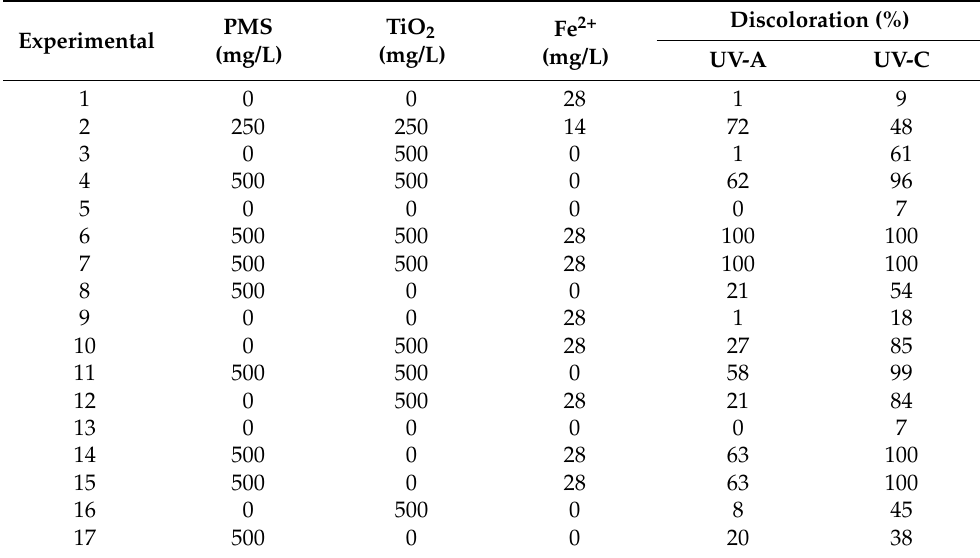
Table 2. Design matrix and methylene blue discoloration results obtained by UV-A and UV-C exposure.